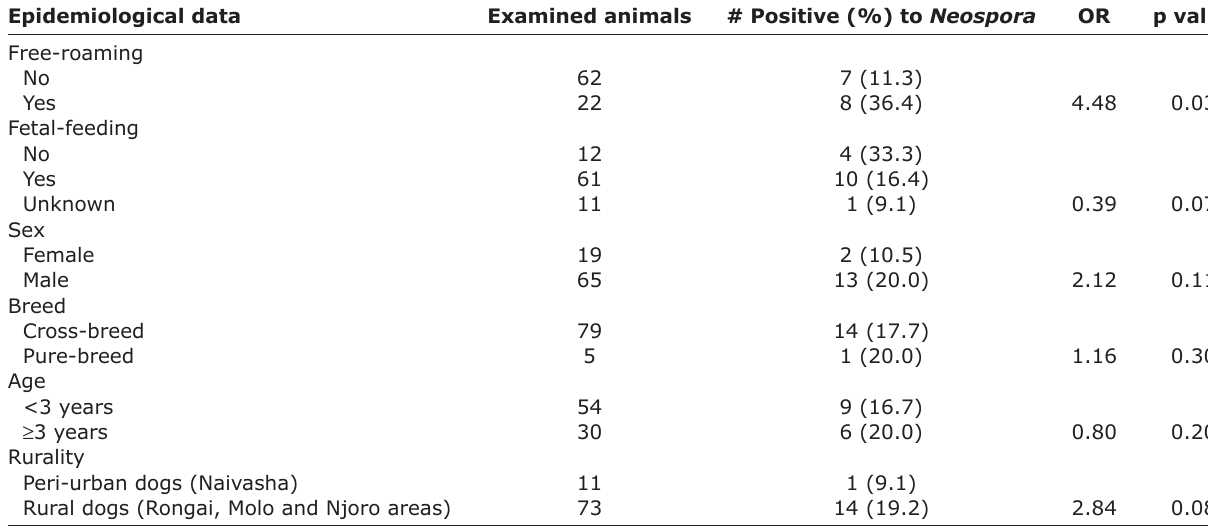
Table-1: Descriptive statistics and univariable associations between seropositivity for NC and epidemiological data for 84 dogs on 53 dairy farms in Nakuru District, Kenya in 2010. Epidemiological